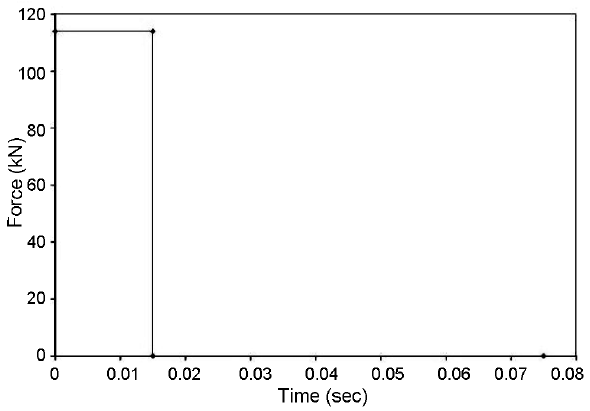
Fig. 4. Impulse-shape load (KTMB 2003) Table 1. Material properties No.